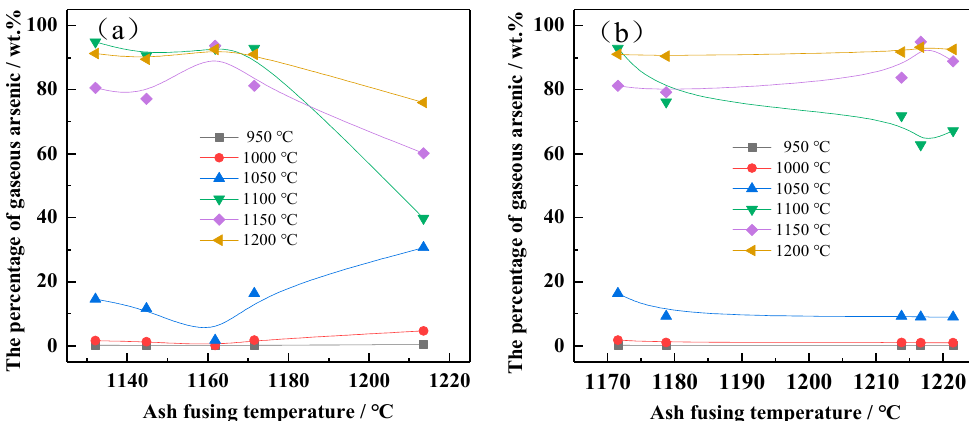
Figure 5. Relationship between the ash fusion temperature (AFT) and arsenic volatilization under different combustion temperatures: ( a ) CaO addition, ( b ) Al 2 O 3 addition.